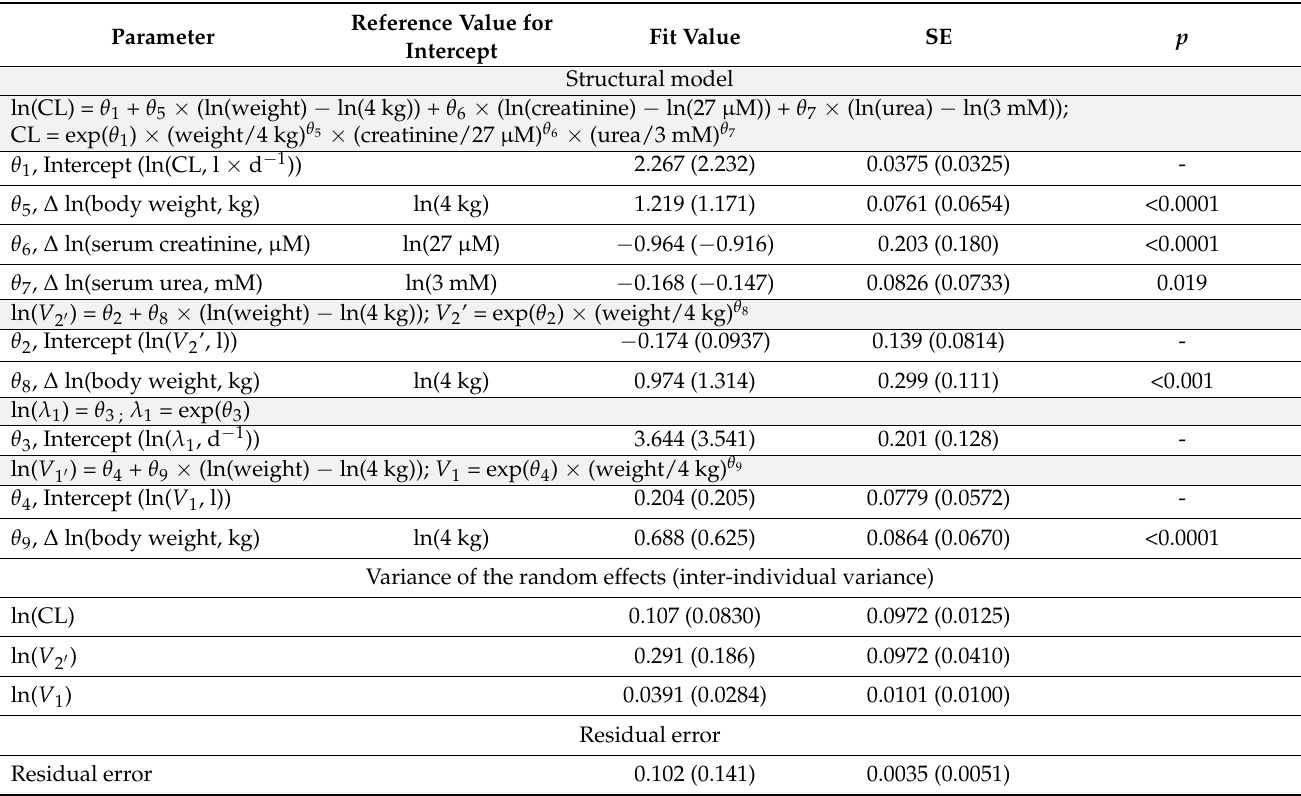
Table 3. Fit parameters with SE and p of the final model. Values in parentheses are results when setting concentrations below the LOQ to LOQ/2 (0.15 mg/L). Reference Value for Parameter Fit Value SE p Intercept Structural